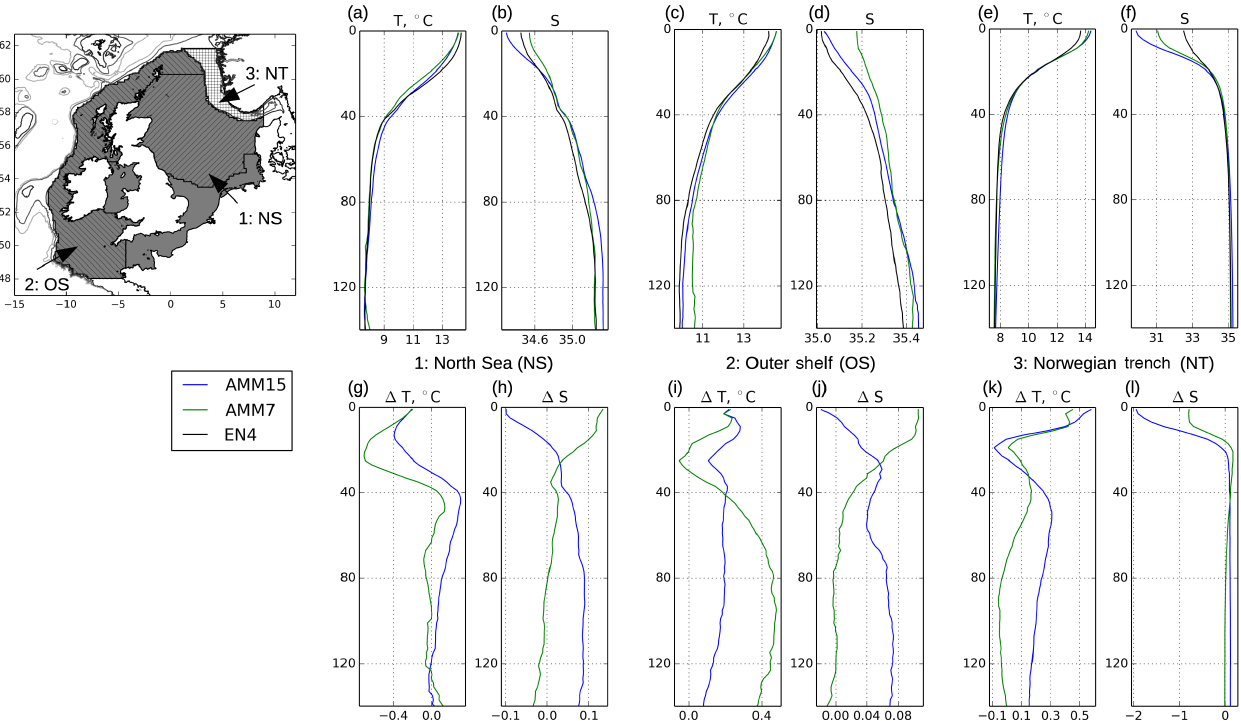
Figure 6. Mean summer (JJA) temperature ( ◦ C) and salinity profiles for three stratified regions shown as hatched regions in the upper left panel: North Sea (NS), outer shelf (OS), and Norwegian Trench (NT). All panels show 20-year mean profiles for JJA, 1991–2010. Observations (black) are monthly EN4 profiles (Good et al., 2013). Upper panels (a–f) show mean profiles with depth, lower panels (g–l) show anomalies with depth for respective profiles, where (cid:49)T = (T AMM − T EN4 ) . Results from AMM15 and AMM7 are shown in blue and green,